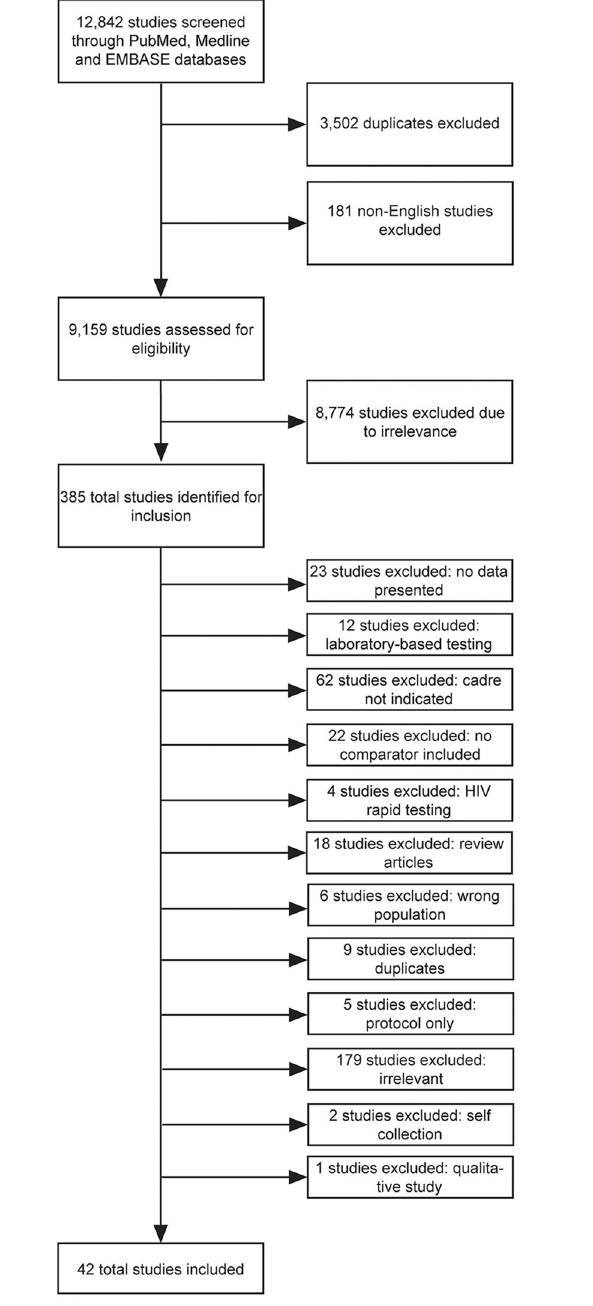
Fig 1. PRISMA flow